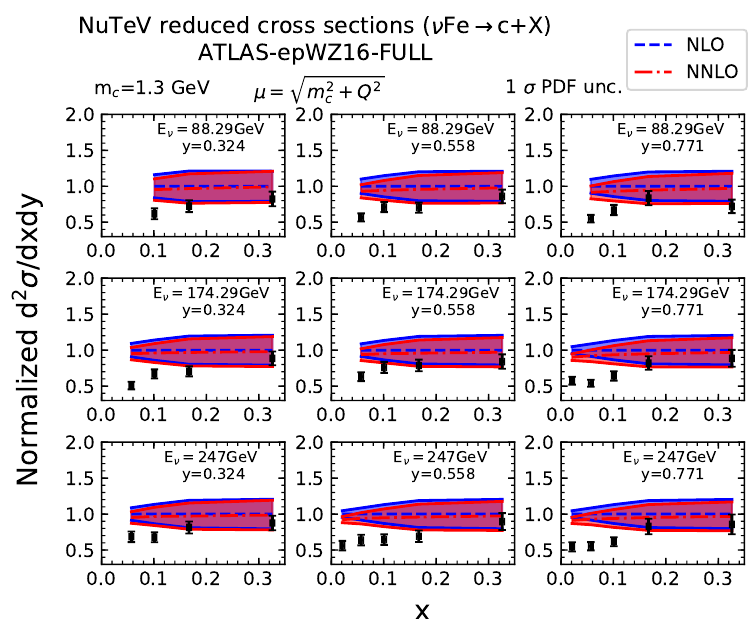
Figure 9 . NLO and NNLO predictions on charm quark production cross sections using ATLAS- epWZ16 NNLO PDFs comparing with the NuTeV measurement. Also shown are the 1 (cid:27) PDF uncertainties. The experimental data have been corrected for nuclear e(cid:11)ects. The error bars represent the total experimental uncertainties rescaled by square root of the e(cid:11)ective degree of freedoms. A 10% normalization uncertainty due to the semi-leptonic decay BR of charm quark is not shown here.